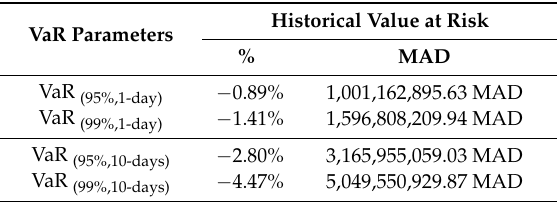
Table 2. Calculation of the historical Value at Risk (VaR) for 30 June 2017.